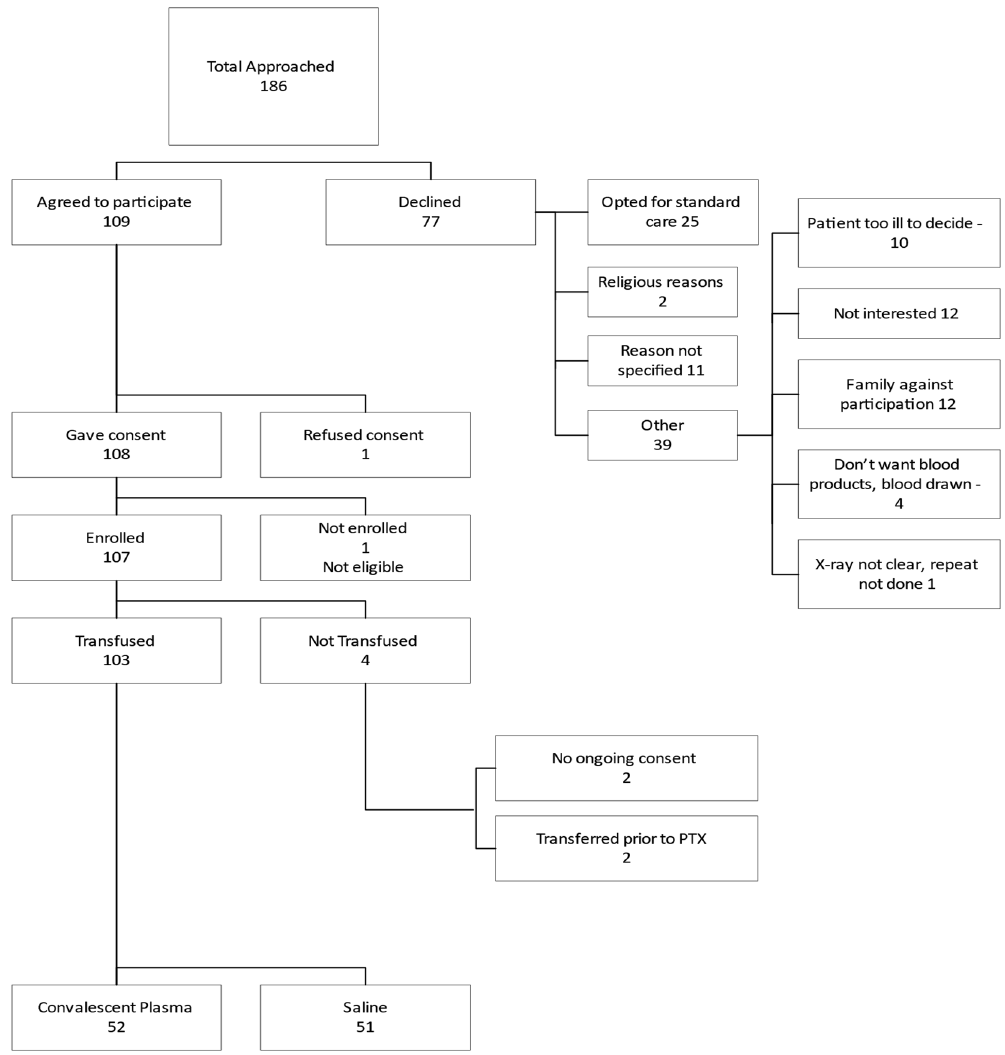
Figure 1. Consort diagram illustrating numbers of participants with moderate-severe COVID-19 randomized (1:1) to treatment with convalescent plasma or